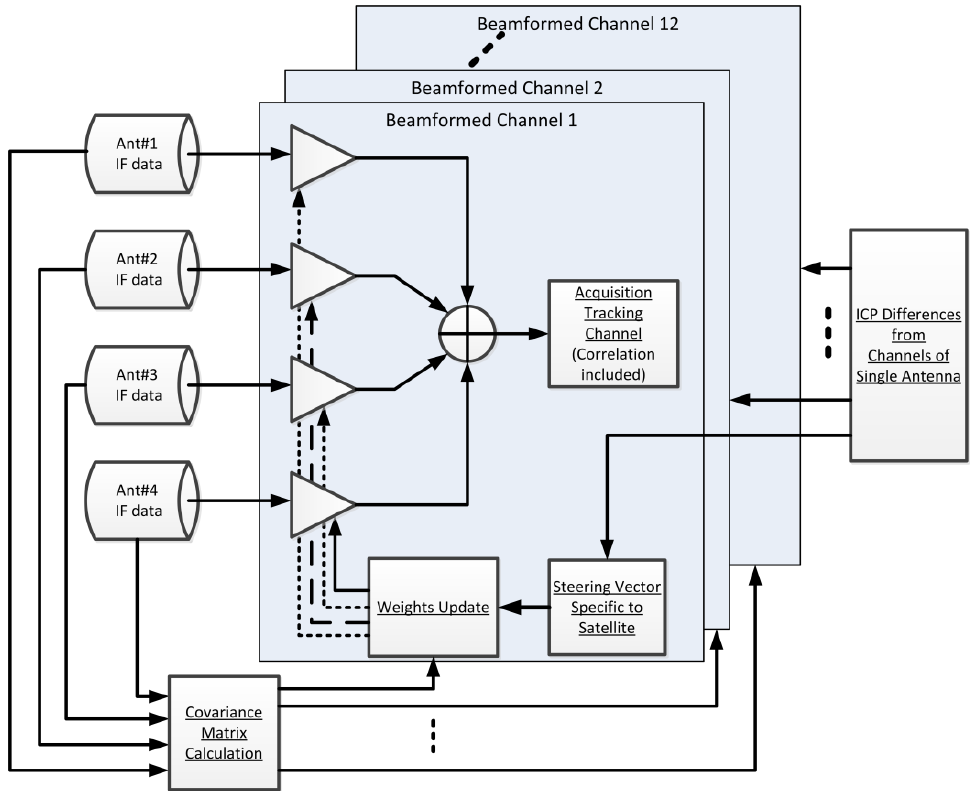
Figure 4. Beamforming architecture for steering 12 beams simultaneously using the MVDR algorithm.